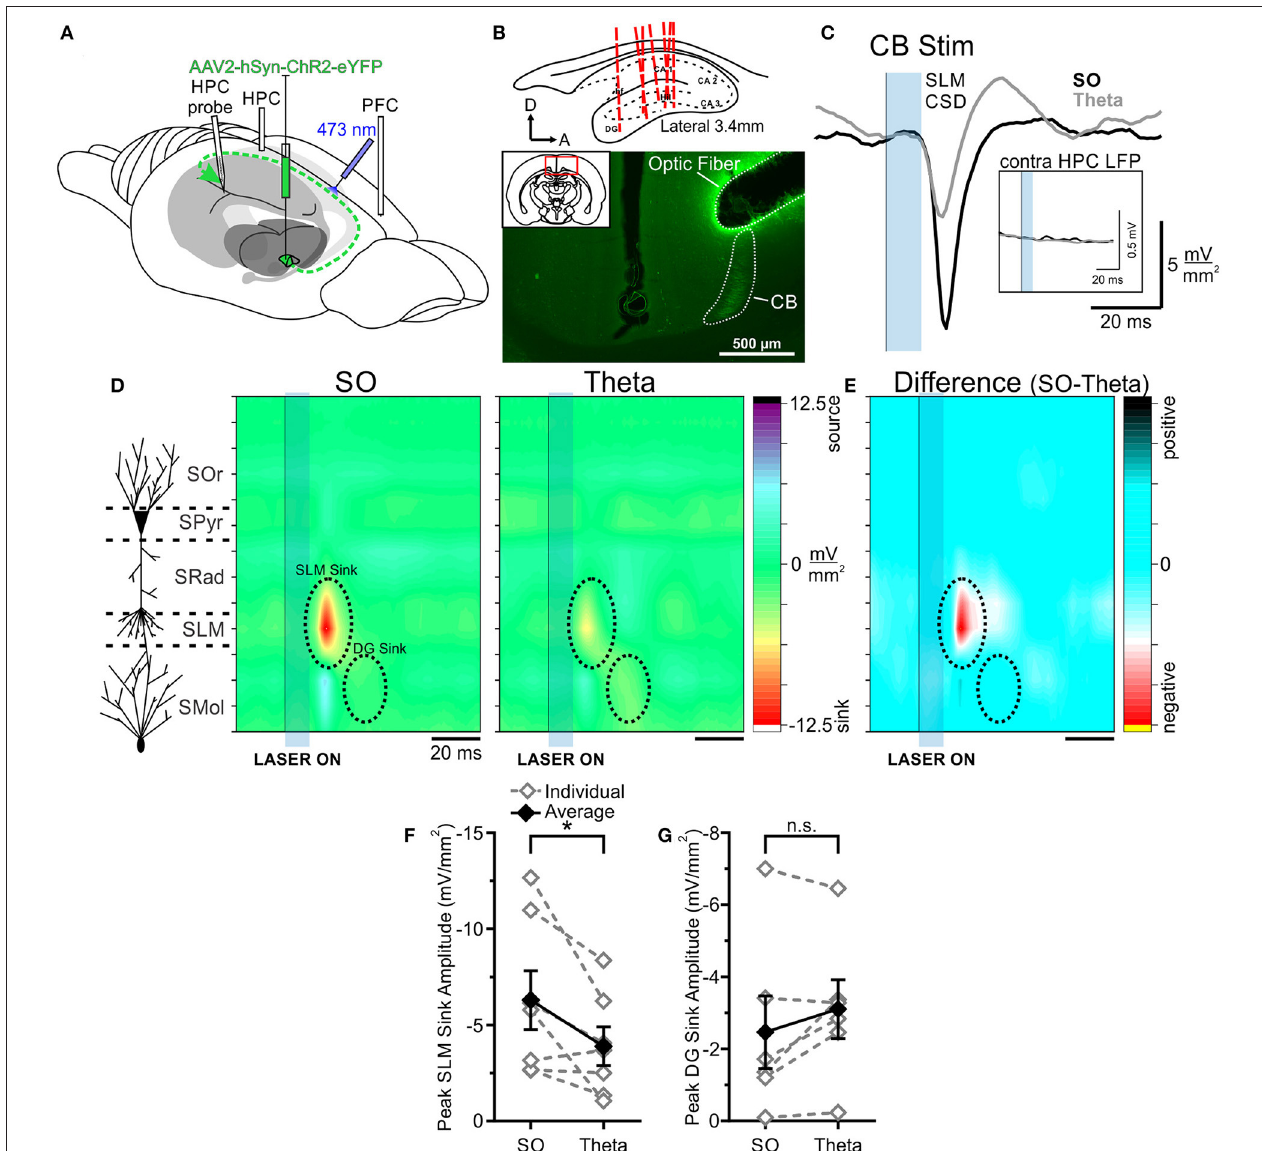
FIGURE 5 | Optogenetic stimulation of the cingulum bundle (CB) evokes a larger response in HPC during SO. (A) Schematic illustration of the recording, injection, and stimulation sites. Schema modified from Amaral and Witter (1995). (B) Top, Schematic sagittal illustration of all multiprobe tracks through HPC. Bottom, Representative coronal tissue section depicting hSyn-ChR2-EYFP viral expression in CB following a single injection in RE, with optic fiber track positioned dorsolaterally to CB. Inset, Coronal schematic of the relative location (red box) of the image. Histology corresponds to the same animal whose data are depicted throughout this figure. (C) Current sink/source density traces evoked in SLM following optogenetic stimulation (10ms pulse at 473nm wavelength; blue rectangle) of CB during SO (black line) and theta (gray line), averaged over 64 trials. Stimulation of CB during SO produces a much larger current sink in HPC than did stimulation during theta. Inset, Local field potentials recorded from the contralateral HPC following the same optogenetic stimulation of CB during SO (black line) and theta (gray line). There is a total lack of response in the contralateral HPC regardless of state given the ipsilateral projection pathway of RE-to-HPC via the CB. (D) Left, Schematic depiction of HPC cell lamina as determined by theta profile. Color contour plot of CSD values just before and following 10ms optogenetic stimulation of CB (black line and blue rectangle) during SO (middle) and during theta (right). CB stimulation produces a large current sink centered around SLM (with a corresponding current source in DG) which is of greater magnitude during SO compared to during theta. A later DG sink is also evoked by CB stimulation that does not significantly differ in amplitude between states. The overall pattern of responding is effectively identical to that evoked by RE stimulation. CSD scales for both contour plots are identical, from − 12.5 to 12.5 mV/mm 2 . (E) Difference contour plot created by subtracting the theta CSD [ (D) , right] from the SO CSD [ (D) , middle] in the same animal, illustrating that the difference between the two states is largely confined to the SLM sink. The scale of difference contour is − 6.8 to 6.8 mV/mm 2 . (F) Peak SLM sink amplitude evoked by optogenetic stimulation of CB during SO and theta in the same individual animals (gray, hollow diamonds, and dashed gray lines) and on average (black, filled diamonds, and solid black line). A significantly larger sink at SLM is evoked during SO than during theta. (G) Peak DG sink amplitude evoked by optogenetic CB stimulation across both states, in individuals (gray, hollow diamonds, and dashed gray lines) and on average (black, filled diamonds, and solid black line), showing no significant difference across states. Error bars represent SEM. * p < 0.05. SOr, Stratum oriens; SPyr, stratum pyramidale; SRad, stratum radiatum; SLM, stratum lacunosum-moleculare; SMol, stratum